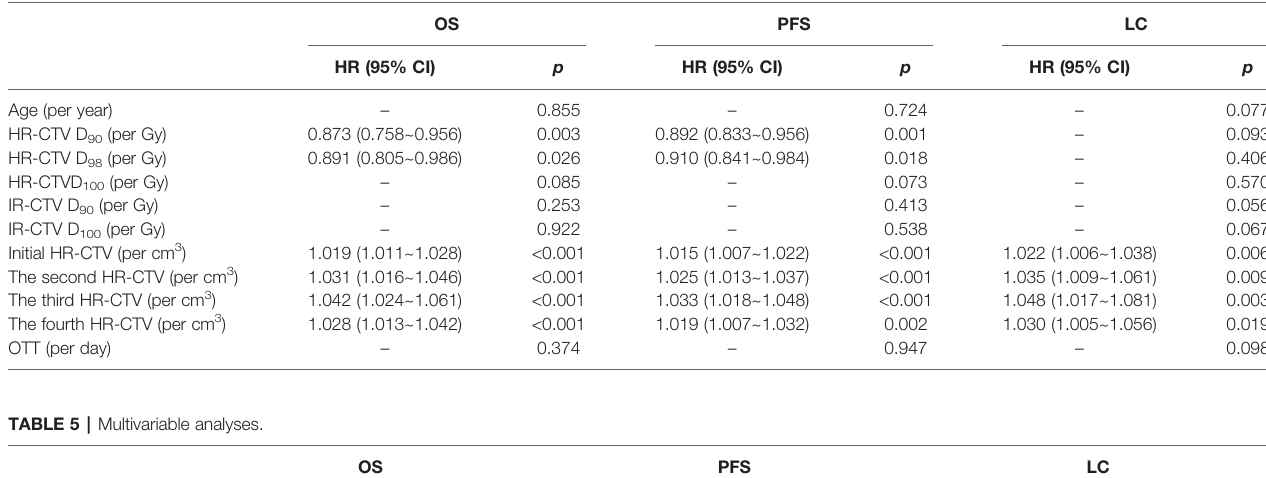
TABLE 4 | Univariable analyses (continuous variables).